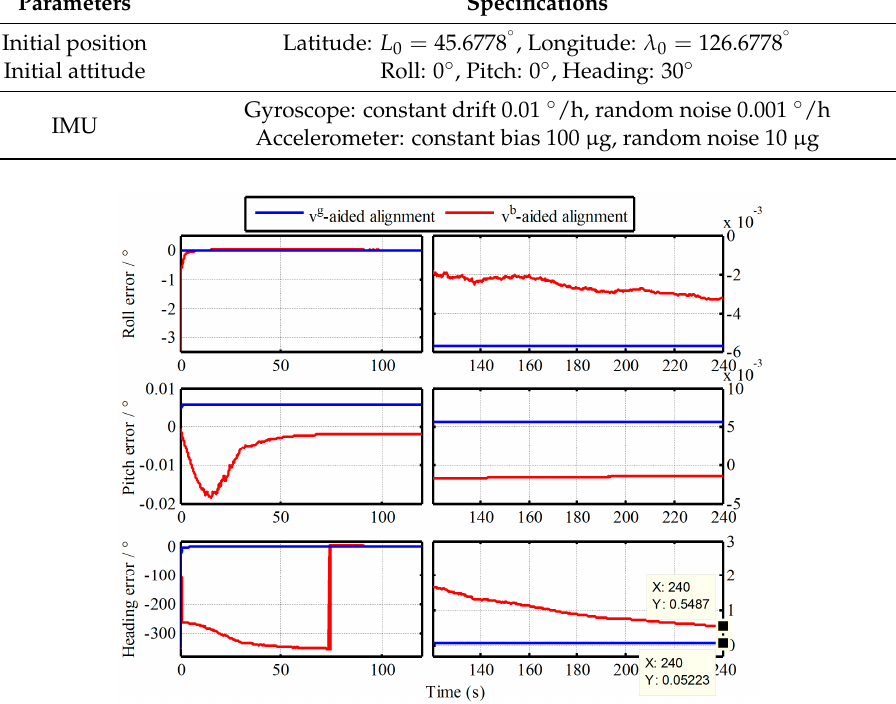
Figure 2. Comparison result of IMADA aided by two different velocity models.